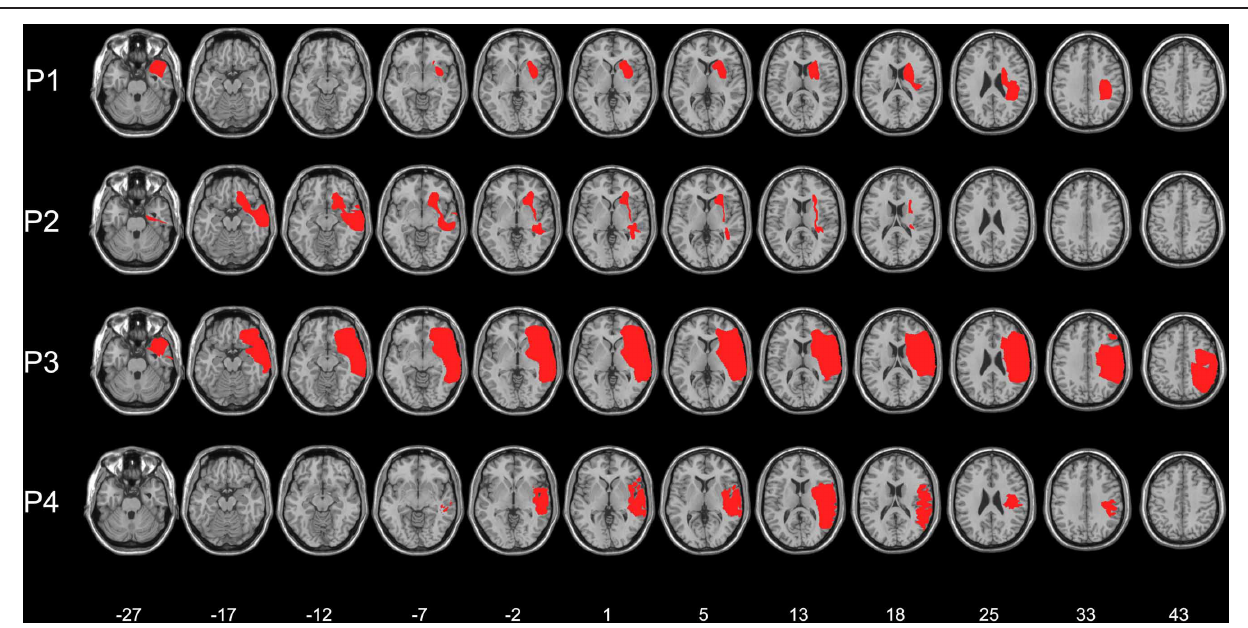
FIGURE 1 | Lesion maps of the four right-brain-damaged patients (see text for details). Each individual lesion was superimposed onto a standard brain format conforming to stereotactic space. Montreal Neurological Institute (MNI) Z-coordinates of each transverse section are shown.